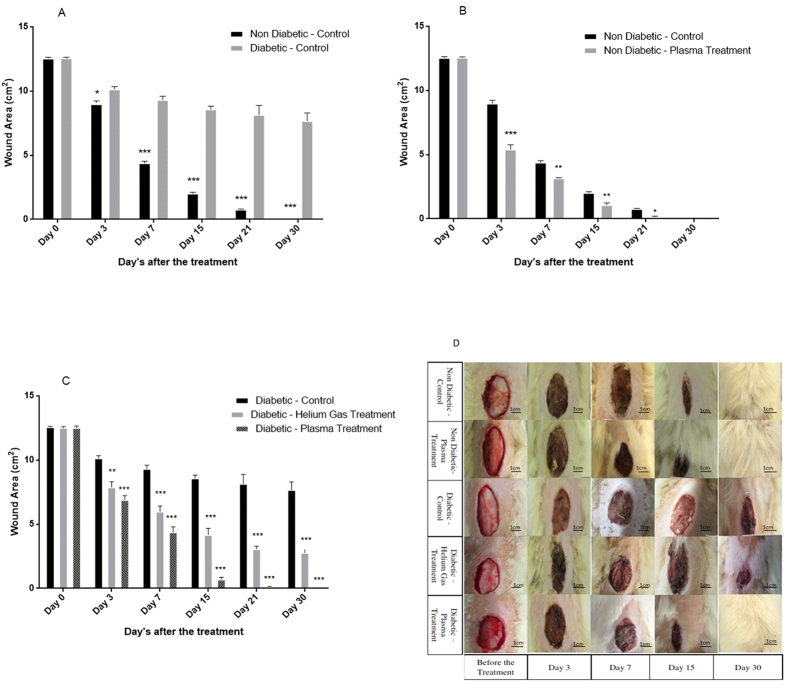
(A) Wound area measurement in non-diabetic and diabetic rats during days 3, 7, 15, 21 and 30 after the plasma treatment. Wound area expressed in cm2 mean ± S.D. (*p < 0.05, ***p < 0.001-compared with the control in same day). (B) Change in the wound closure area at days 3, 7, 15, 21 and 30 after the plasma treatment in non-diabetic models. Wound area expressed in cmλ mean ± S.D. (***p < 0.001 (compared with control in same day), **p < 0.01, *p < 0.05). (C) Change in the wound closure area at days 3, 7, 15, 21 and 30 after the plasma treatment in diabetic models. Wound area expressed in cm2 and mean ± S.D. (**p < 0.01, ***p < 0.001-compared with control in each day). (D) Wound observation for days 3,7,15 and 30 after the treatment.